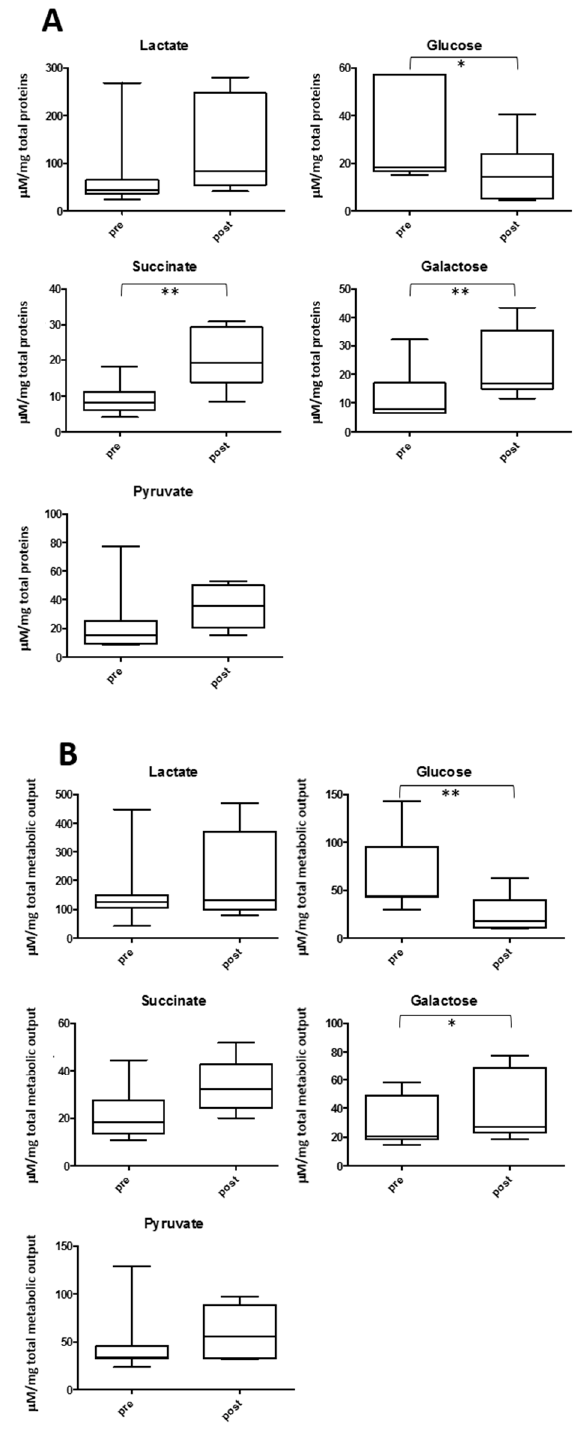
Figure 7. The concentration changes between pre- ( left ) and post-samples ( right ) in energy-related metabolites in saliva using TPWS ( A ) or TOMC ( B ) data normalization. In A metabolite concentrations are expressed as µ M / mg of total proteins, in B as µ M / total metabolic output. The boxes denote interquartile range, lines denotes median, whiskers denotes 5th and 95th percentile. * p < 0.05; ** p < 0.01.